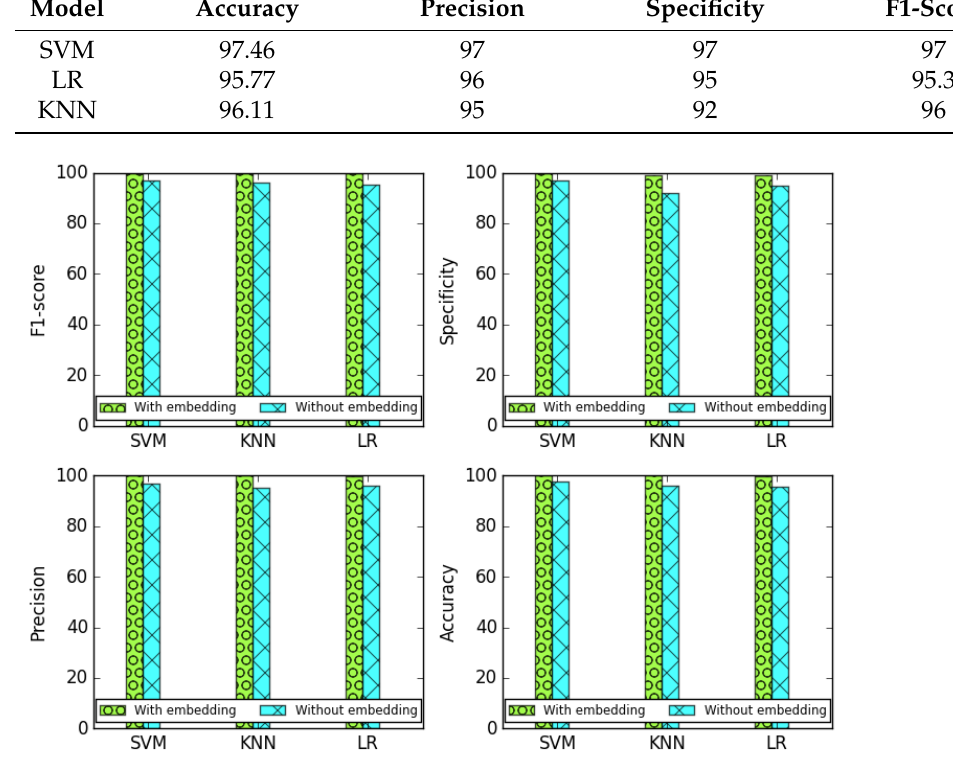
Figure 12. Comparison of the classification quality with and without incremental